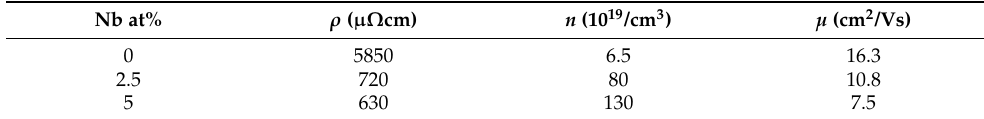
Table 1. Resistivity, carrier density and mobility (at room temperature) of the least resistive TiO 2 − x :Nb films sputtered on unheated glass with a SiN capping layer and annealed at 300 ◦ C.